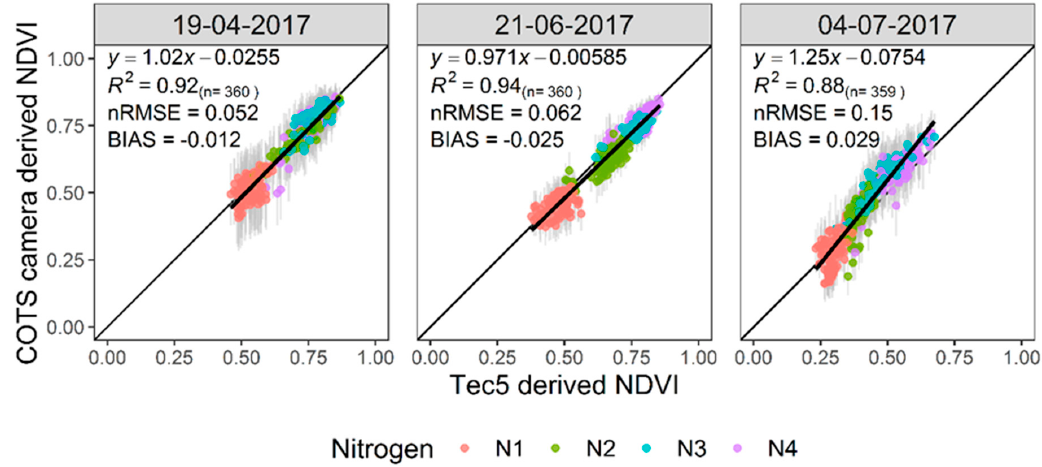
Figure 15. Accuracy assessments COTS camera-derived NDVI for three dates. The points are coloured based on nitrogen treatment applied to the plot. Standard deviation of reflectance measured by the COTS cameras is presented by vertical error bars. The dashed line represents the 1:1 line.